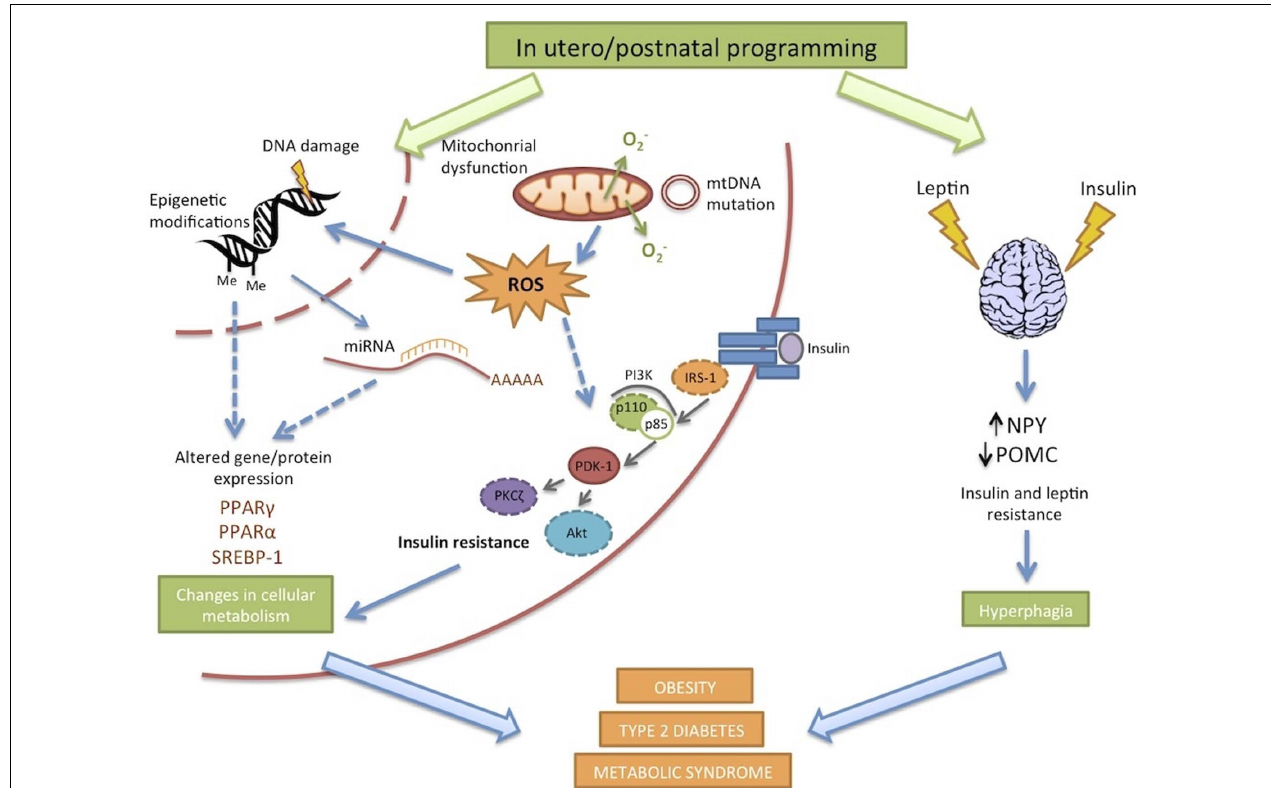
FIGURE 2 | Potential mechanisms of developmental programming in response to maternal